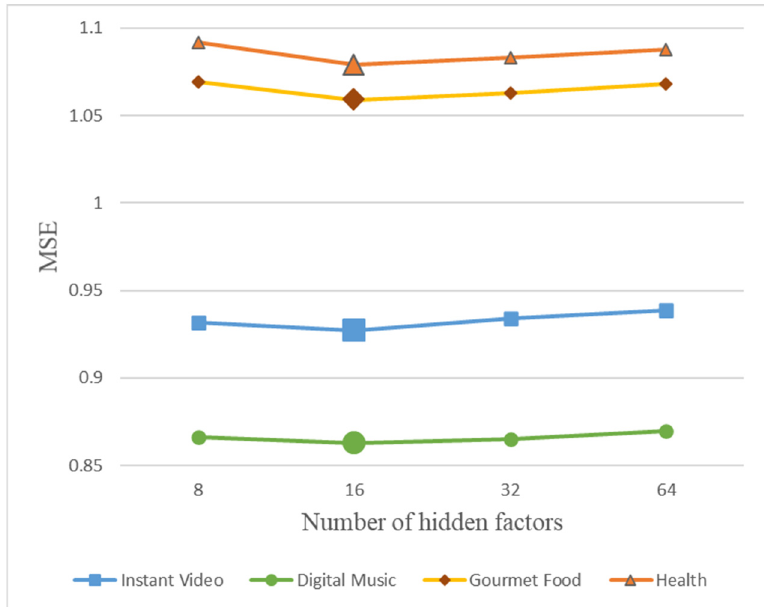
Figure 2. Effect of the number of hidden factors on model performance.